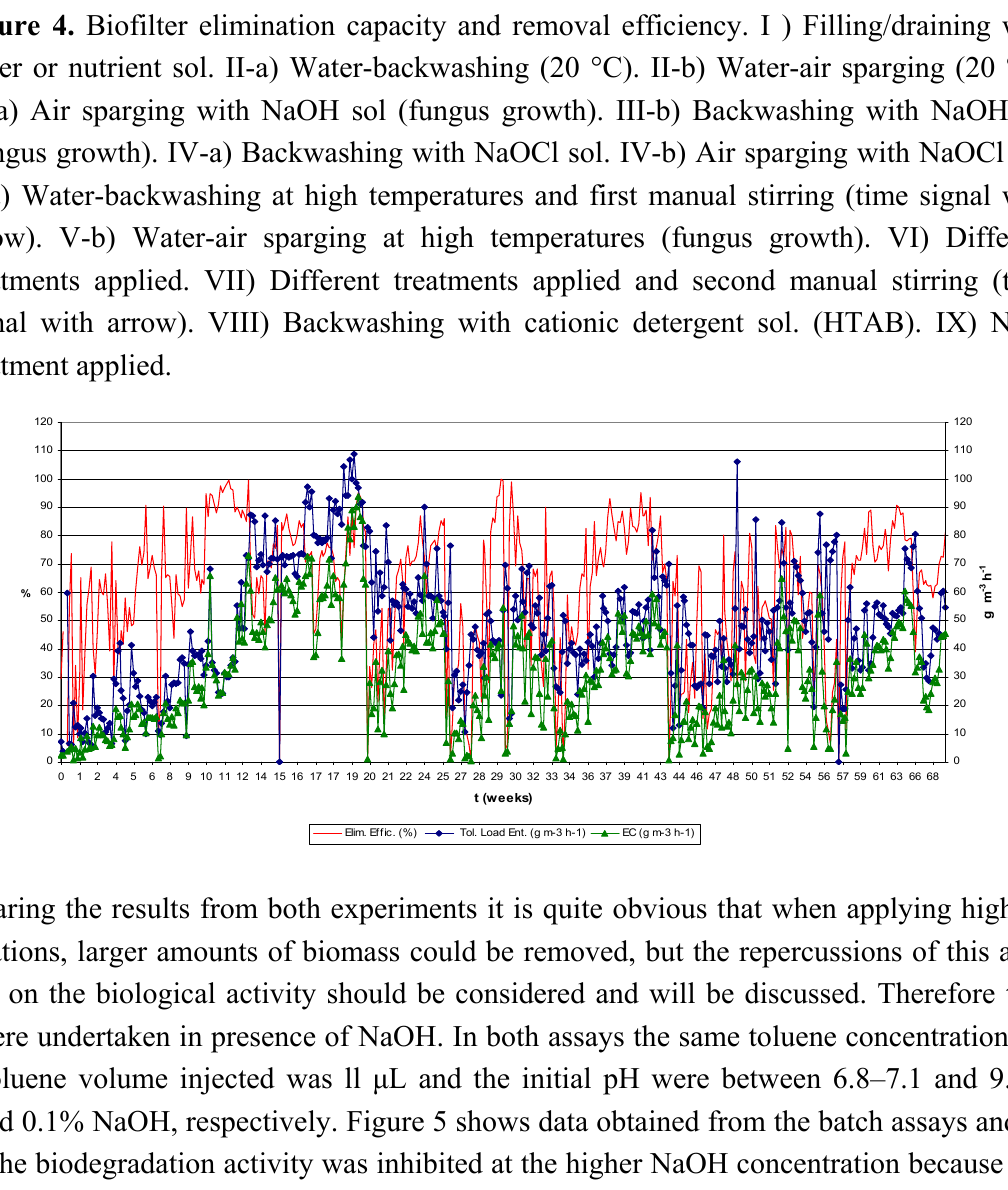
Figure 4. Biofilter elimination capacity and removal efficiency. I ) Filling/draining with